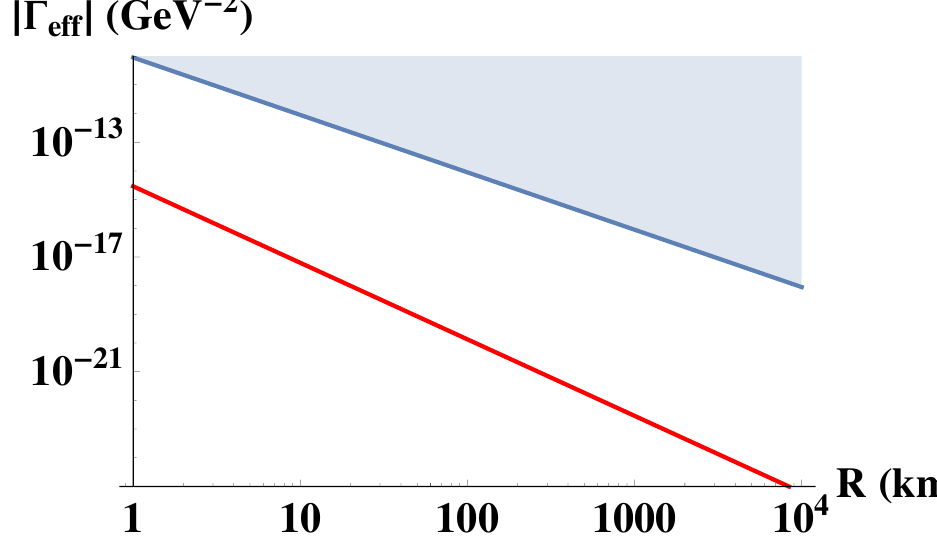
Figure 3. Preliminary results: constraints on a general scalar “DM blob” model with quadratic interactions as per Equation (7), for the average time between encounter region is the preliminary constraints found in this work from six years of data from the Cs GPS clocks. The red line shows the potential discovery reach for one year of data from a single laboratory optical Sr clock as described in the text. These constraints can be easily rescaled into those for a derivative portal coupling strengths via Equation